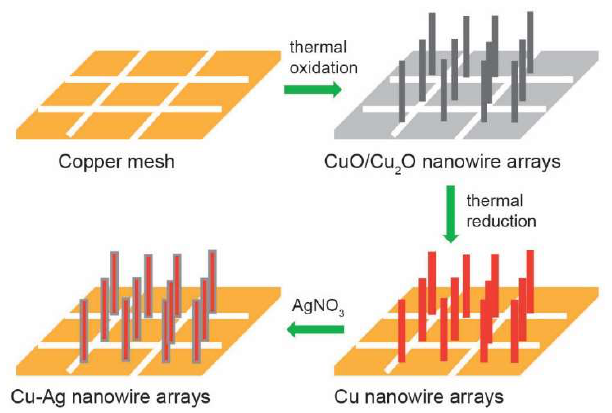
Figure 1. Schematic illustration of the synthesis of Cu–Ag nanowire (NW) arrays.